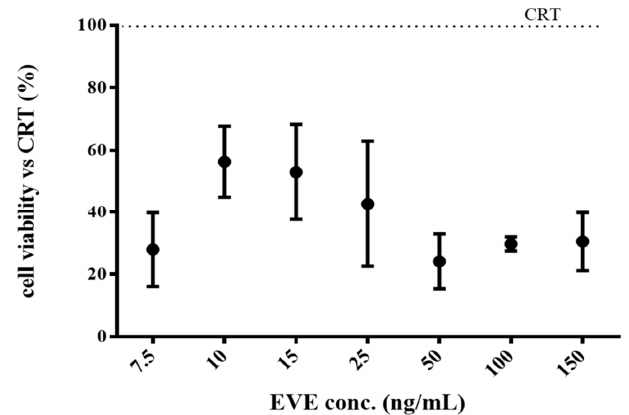
Figure 6. NHDFs proliferation: cells were incubated for 4 h with EVE loaded HA/CS-TPP NPs, then, the NPs were removed and the fresh Dulbecco’s modified Eagle’s medium (DMEM) was replaced. The MTT test was carried out after 24 h.